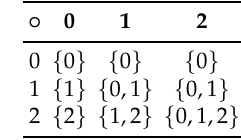
Table 1. Cayley table for the hyperoperation “ ◦